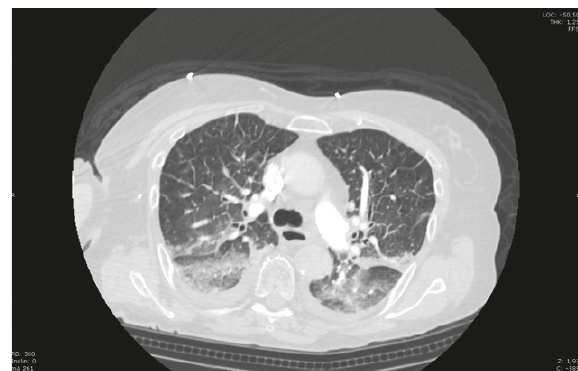
Figure 1: Lung CT scan of the lung.